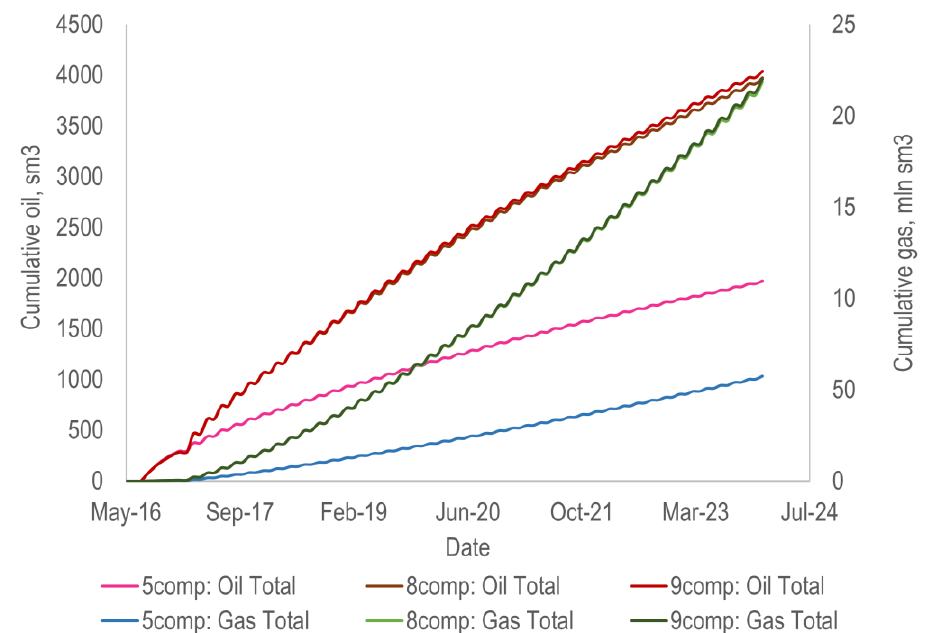
Figure 8. Cumulative production for the five-, eight-, and nine-component models.